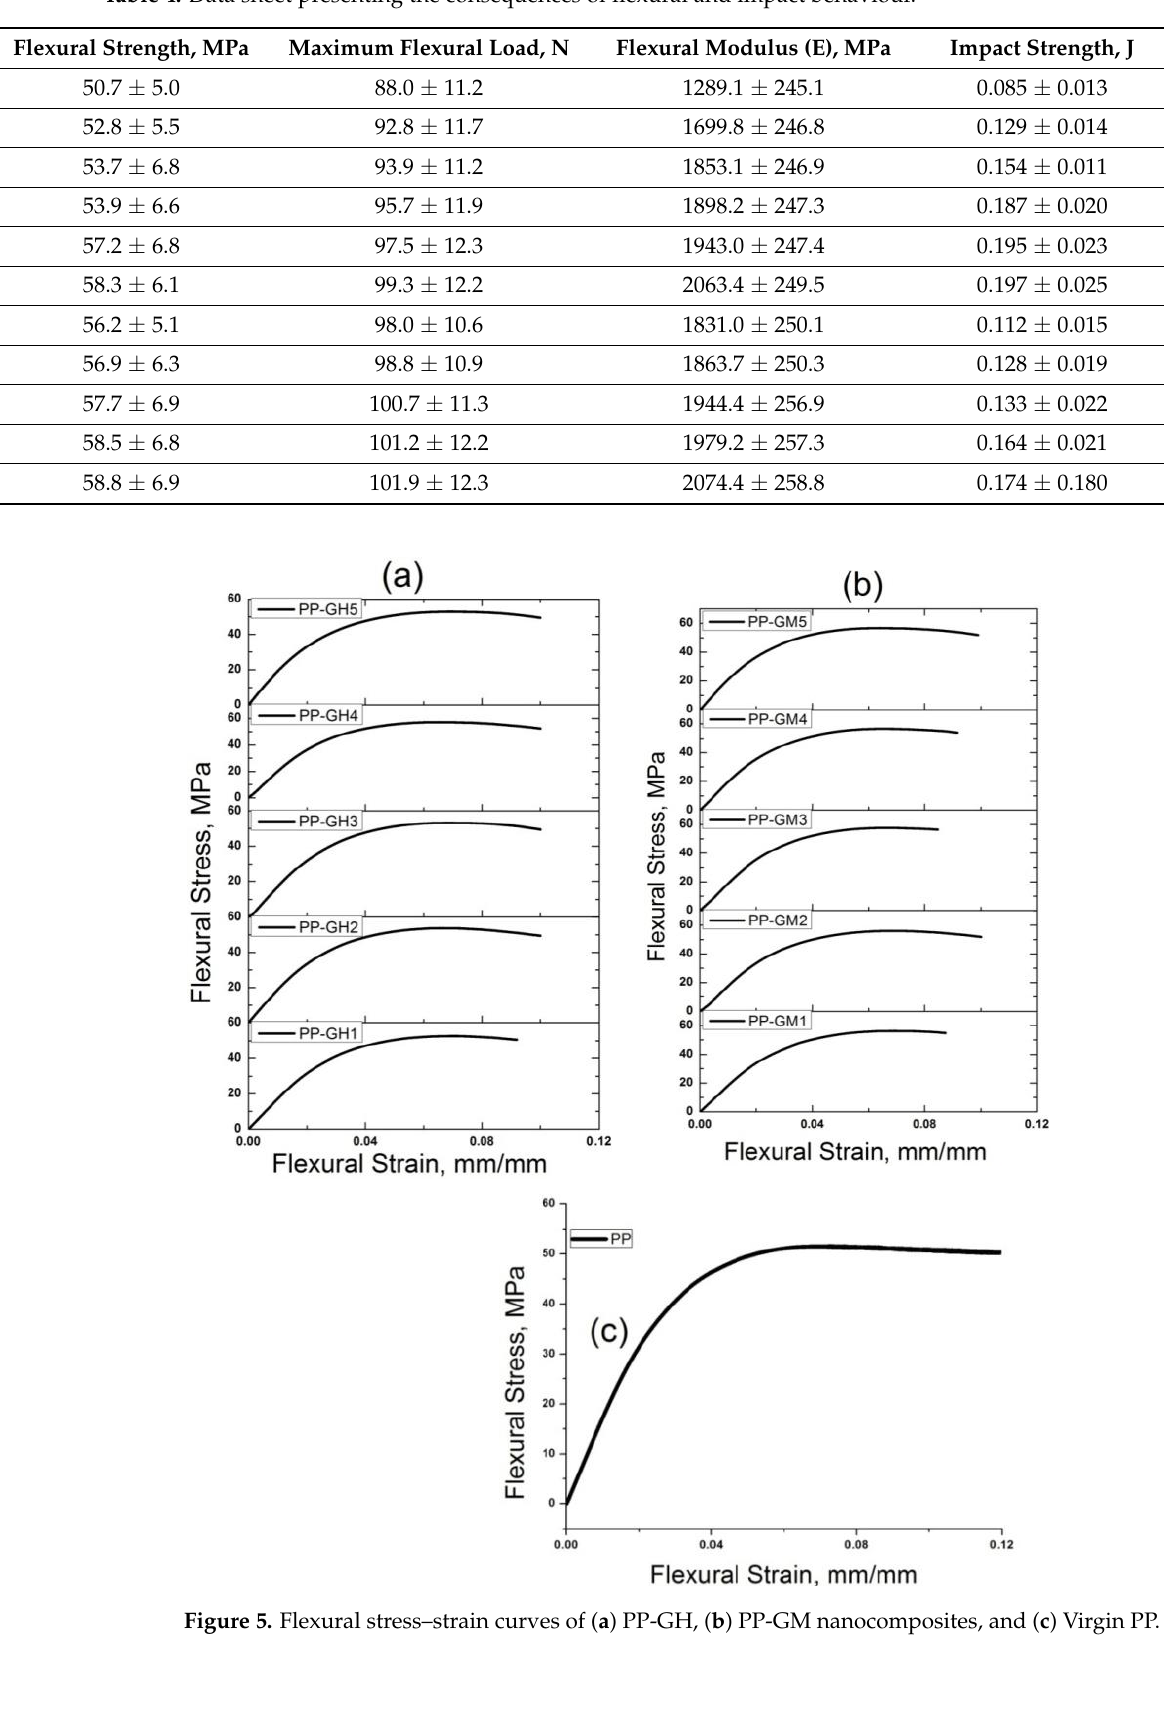
Table 4. Data sheet presenting the consequences of flexural and impact behaviour.